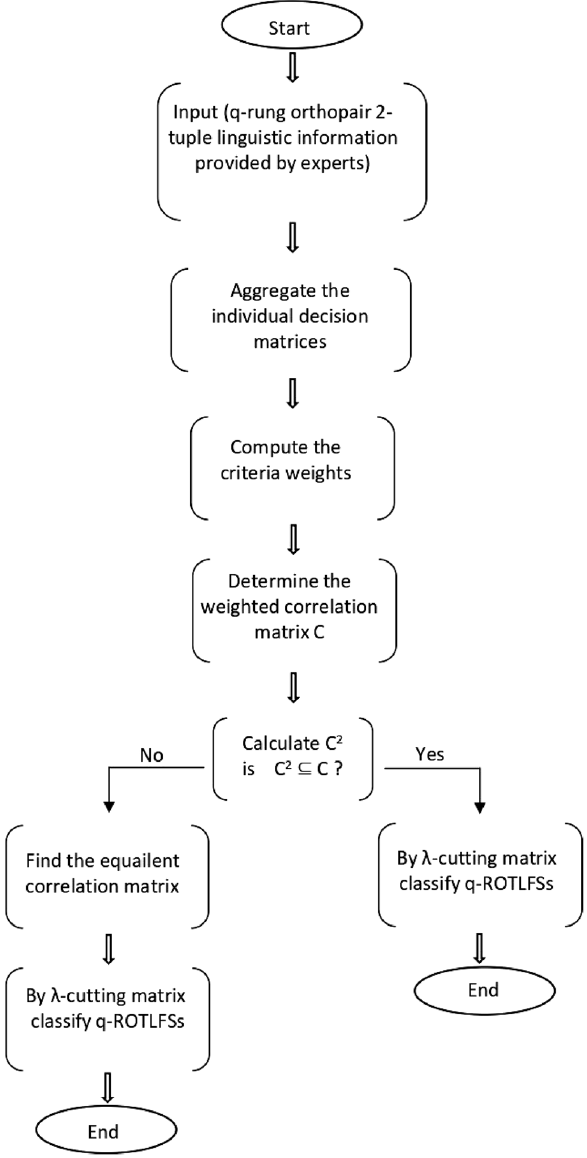
Figure 2. Flow chart of the developed clustering